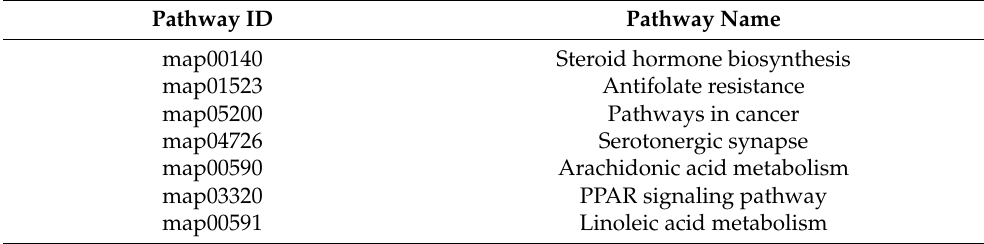
Table 4. Signaling pathways enriched by transcriptomics and